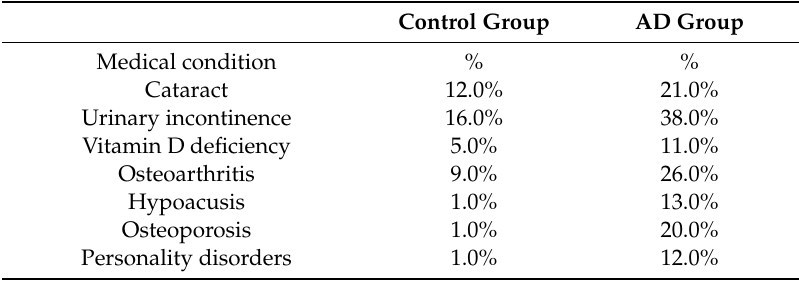
Table 1. Presence of comorbidities with higher incidence in the AD